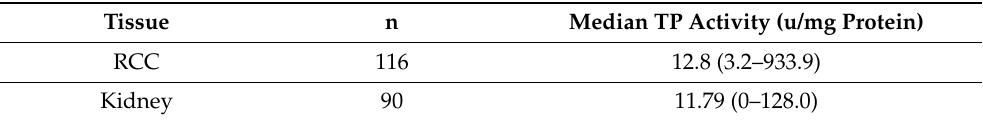
Table 4. Thymidine phosphorylase (TP) is preferentially expressed at a higher activity level in renal cell carcinoma (RCC) tumor cells than non-neoplastic kidney tissue specimens [119], range: ( ). Difference in the activity of TP between RCC and kidney is significant, with p < 0.0001. Tissue